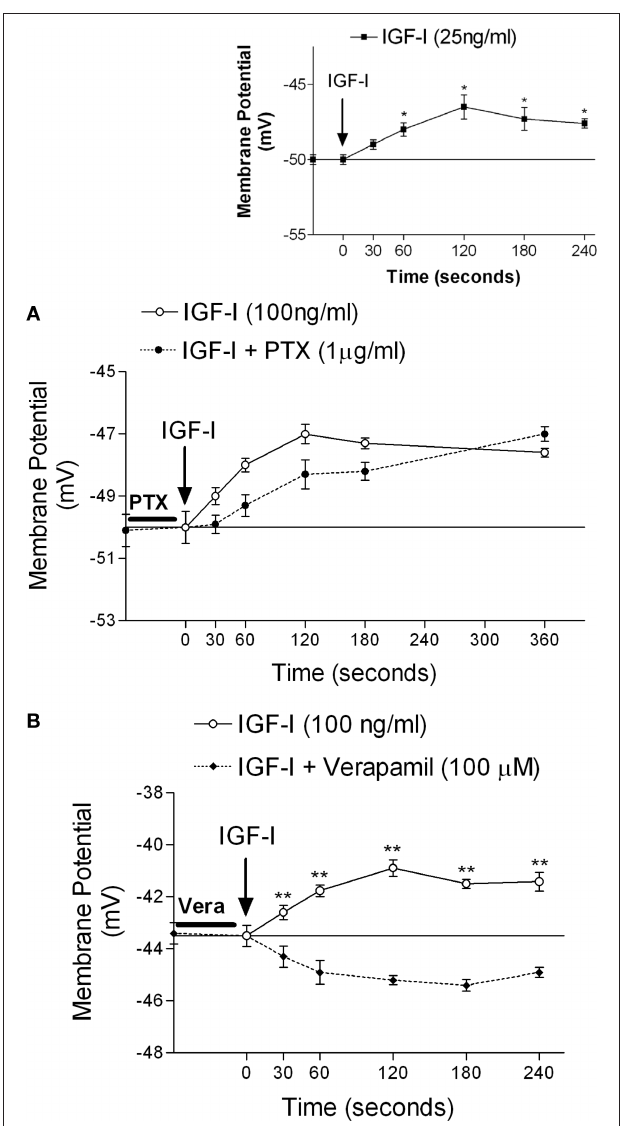
FiGure 3 | rapid depolarization of immature Sertoli cells produced by topical application of iGF-i (25 ng/ml) (A, inset). The IGF-I depolarization time course was not affected by pre-incubation with PTX (1 μg/ml) (A) , but was nullified by the presence of verapamil (100 μM) (B) . Sertoli cells were pre-incubated with PTX for 1 h before IGF-I application, and verapamil was perfused 10 min before IGF-I application. * p < 0.05; n = 5 in each time from five independent experiments; ** p < 0.001; n = 6 in each treatment (IGF-I or IGF-I plus verapamil) from five separated